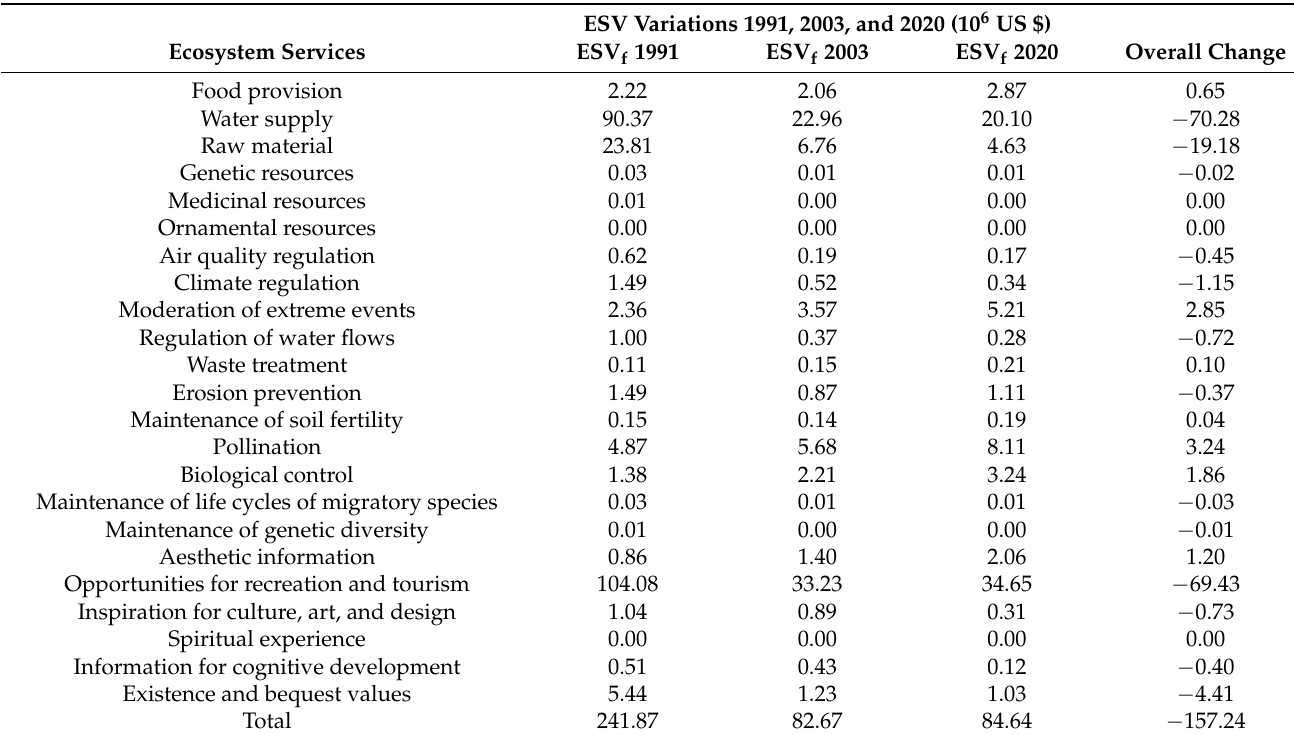
Table 7. Individual Ecosystem services values for the Matenchose watershed (1991–2020) in Millions of USD $/ha/yr.